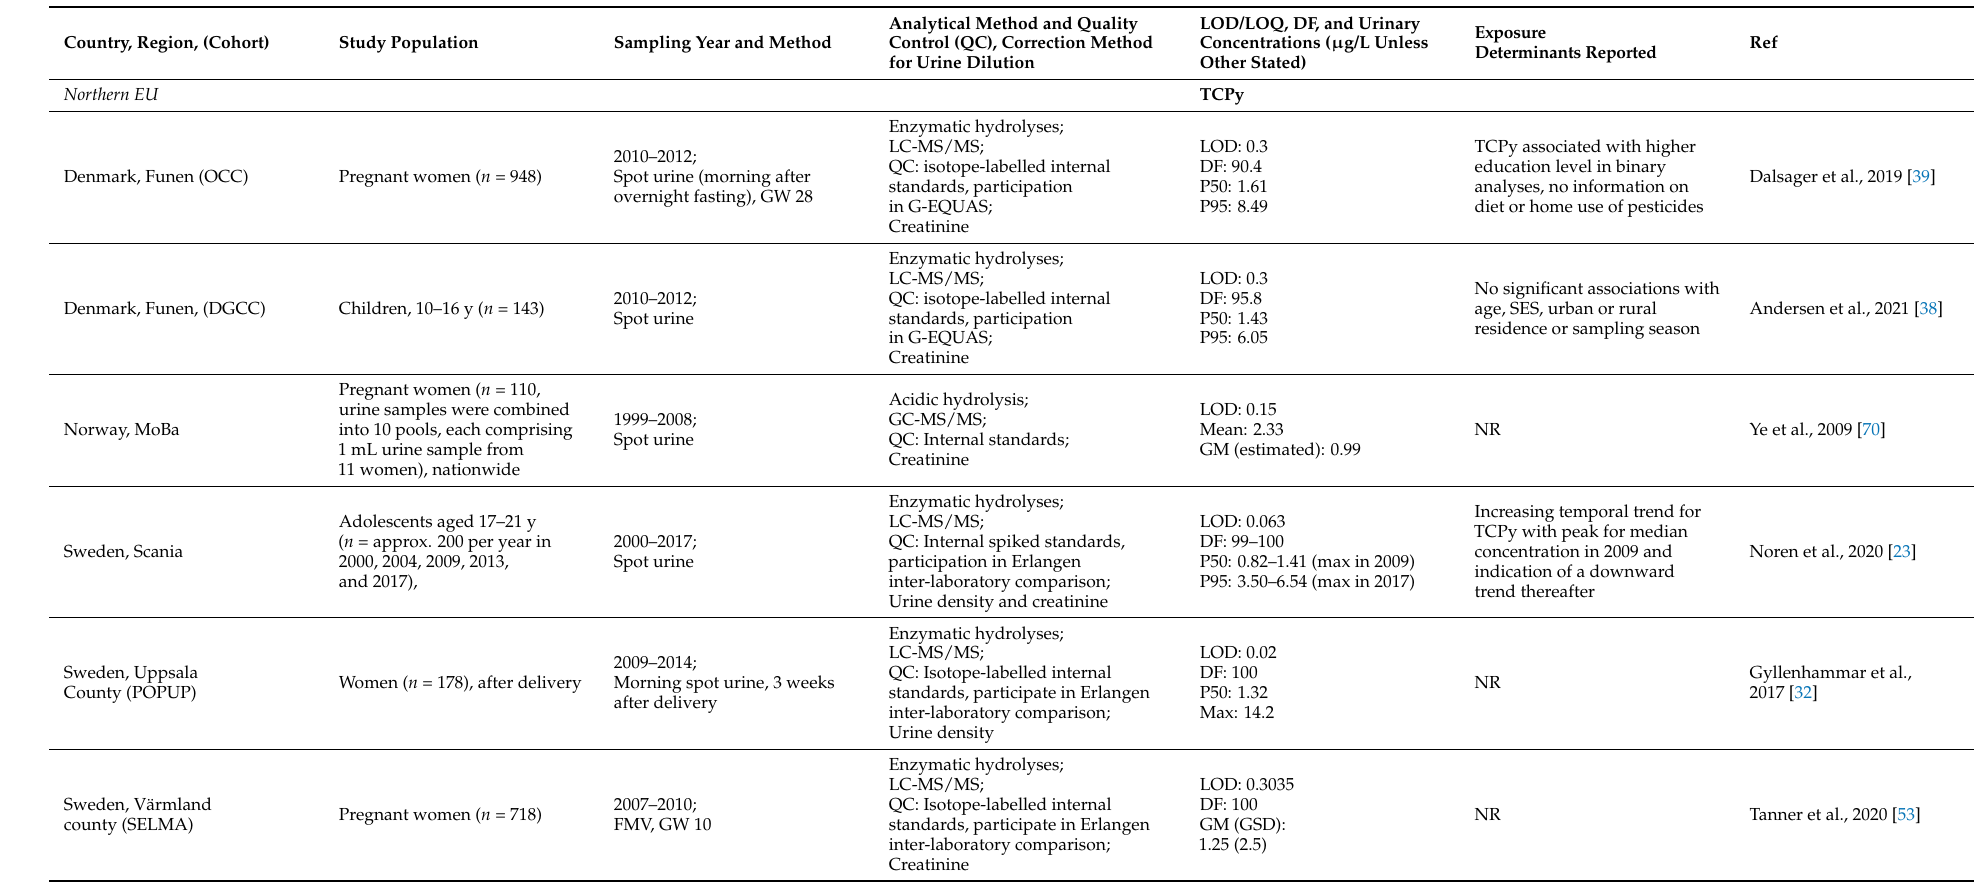
Table 3. Human biomonitoring studies of chlorpyrifos/chlorpyrifos-methyl exposure based on urine samples from European